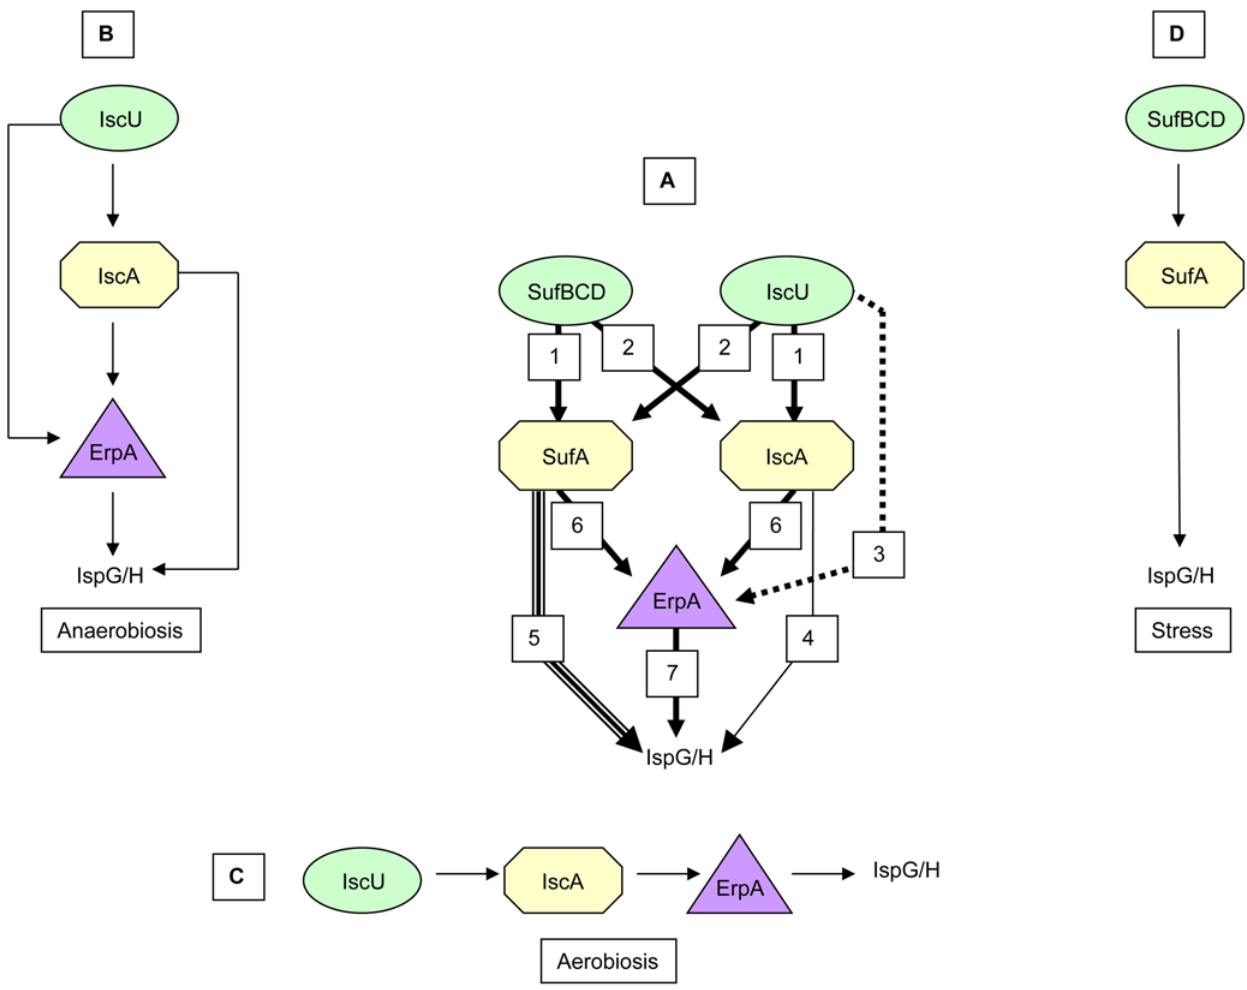
Figure 3. Model for Fe/S trafficking leading to IspG/H maturation in E.coli . Diagram depicted in panel (A) shows all possible Fe/S paths deduced from the present study and from the current literature. Path 1 was deduced from the observation that sufA acts as a multicopy suppressor of the iscUA erpA strain in a sufB -dependent manner and from in vitro studies ([48] and Fontecave’s group personal communication). Path 2 was deduced from the viabilities of the iscA sufB , iscA sufCD and iscU sufA mutants. Path 3 was deduced from the observations that (i) erpA acts as a multicopy suppressor of the iscA sufA mutant in an iscU -dependent manner; (ii) the sufA iscA mutant is viable under anaerobiosis only in the presence of functional copies of iscU and erpA . Path 4 was deduced from the anaerobic-dependent growth of the D suf erpA mutant. Path 5 was deduced from the observation that sufA acts as a multicopy suppressor of iscUA erpA . Path 6 was deduced from the identity between the phenotypes of the iscA sufA and erpA mutants and phylogenomic analysis; other interpretations are that: (i) ErpA acts between the IscU/SufBCD and the IscA/SufA components; (ii) IscA, SufA and ErpA interact to build a heteromeric complex. Path 7 was deduced from the observation that multicopy erpA suppresses the iscA sufA conditional lethal phenotype. Diagrams depicted in panels (B), (C), (D) represent models for IspG/H maturation under different growth conditions as indicated under each panel. The situations depicted make use of a minimum number of Fe/S biogenesis components and are meant for describing a cell expressing the Fe/S biogenesis genes involved at their physiological